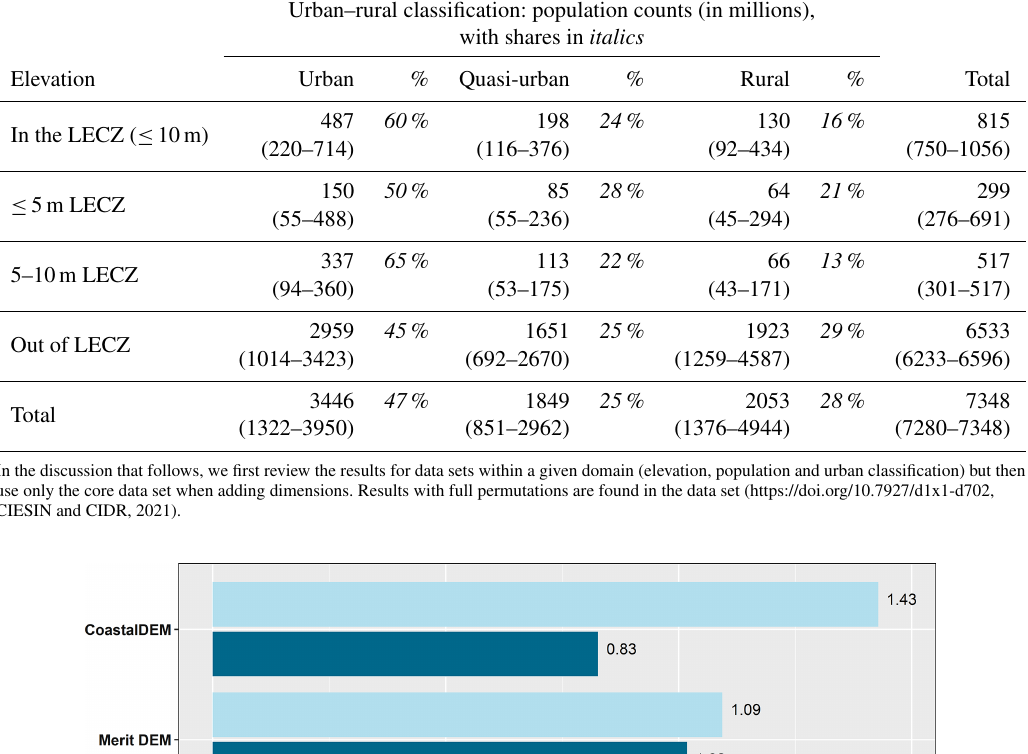
Table 5. Summary of estimates of the global population in the LECZ, by LECZ and urban–rural classes. Core data sets (2015) shown with the range of estimates from other data sets given parenthetically.